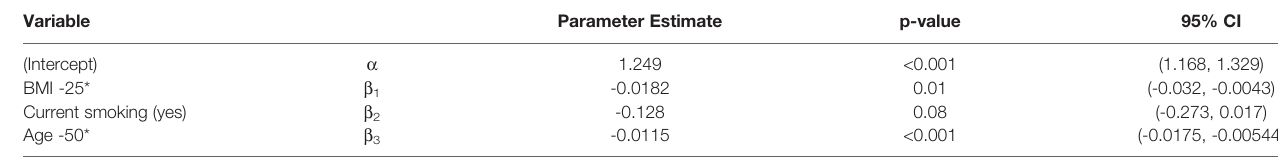
CI, con fi dence interval; BMI, body mass index. R 2 = 0.13 *linear transformation of BMI (minus 25) and Age (minus 50). TABLE 4 | Linear regression for neutralizing antibodies as dependent variable and smoking, age and BMI as covariable. Variable